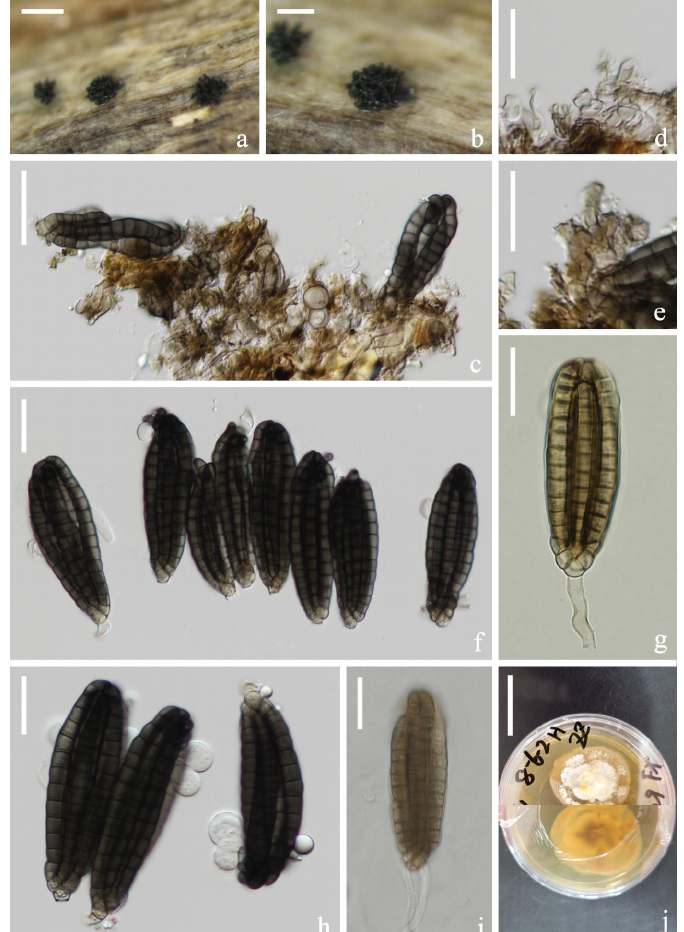
Figure 3. Dictyocheirospora suae (KUN-HKAS 121703, holotype). ( a , b ) Colonies on the substratum. ( c ) Conidiomata. ( d , e ) Conidiophores and conidiogenous cells. ( f ) Conidia. ( g ) Conidiogenous cells with conidia. ( h ) Conidia with appendages. ( i ) Germinating conidium. ( j ) Culture colonies on PDA, reverse (upper) and obverse (lower). Scale bars: ( a ) 200 μ m, ( b ) 100 μ m, ( c ) 30 μ m, ( d – i ) 20 μ m and ( j ) 2 cm.